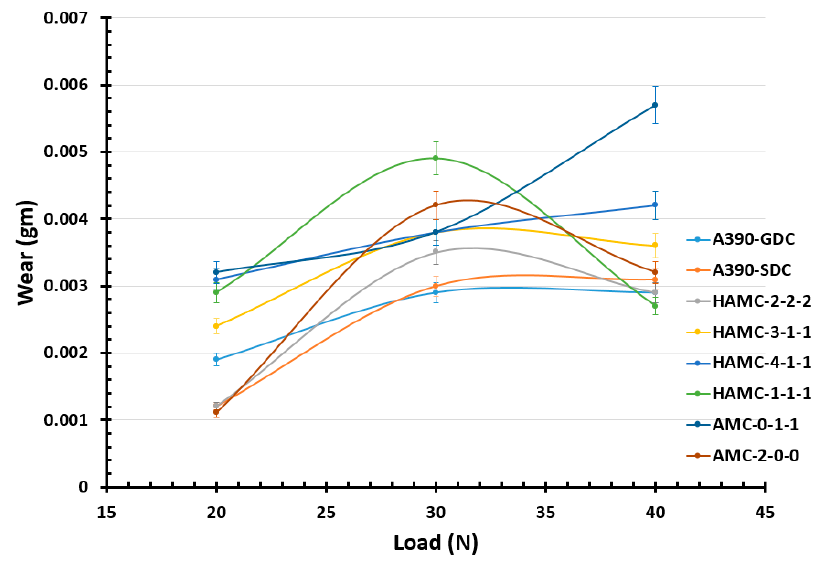
Figure 8. Plot showing the average wear loss of material samples at different wear loads.